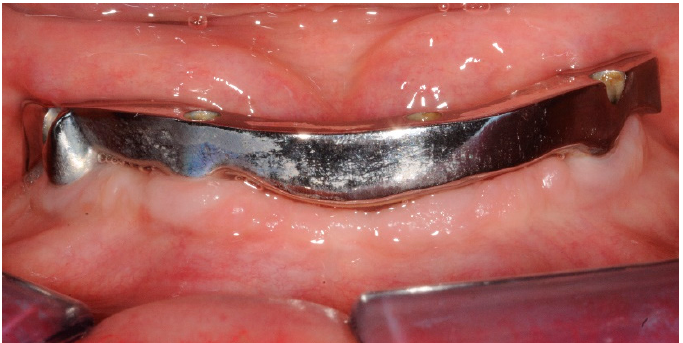
Figure 2. Front view at three years follow up. Good hygiene maintenance and no inflammation of the keratinized mucosa.